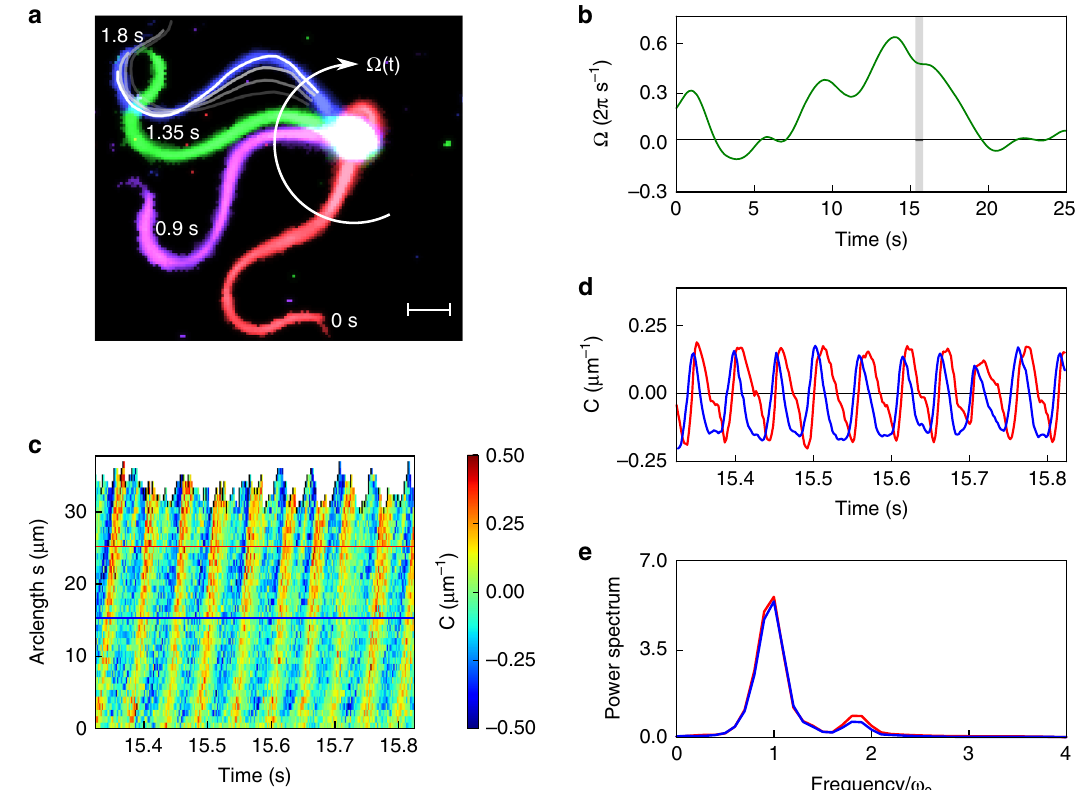
Fig. 1 The fl agellar beat pattern of human sperm displays a second-harmonic component. a Four snapshots of a tethered human sperm that rotates clockwise around the tethering point with rotation velocity Ω ( t ). Each color corresponds to a different snapshot taken at the indicated time. White and gray lines below the blue snapshot show the tracked fl agellum at consecutive frames acquired at 2 ms intervals. Scale bar represents 5 µ m. b Rotation velocity of the cell around the tethering point. The gray area indicates the time interval that is further analyzed in c , d . c Kymograph of the fl agellar curvature during approximately 10 beat cycles (0.5 s). The curvature corresponding to the two horizontal lines is plotted in d . d Curvature of the fl agellum at segments located at 15 μ m (blue) and 25 μ m (red) from the head. The curvature displays a sawtooth-like pro fi le. e Power spectrum of the curvature at 15 μ m and 25 μ m. The fundamental frequency is ω o = 20